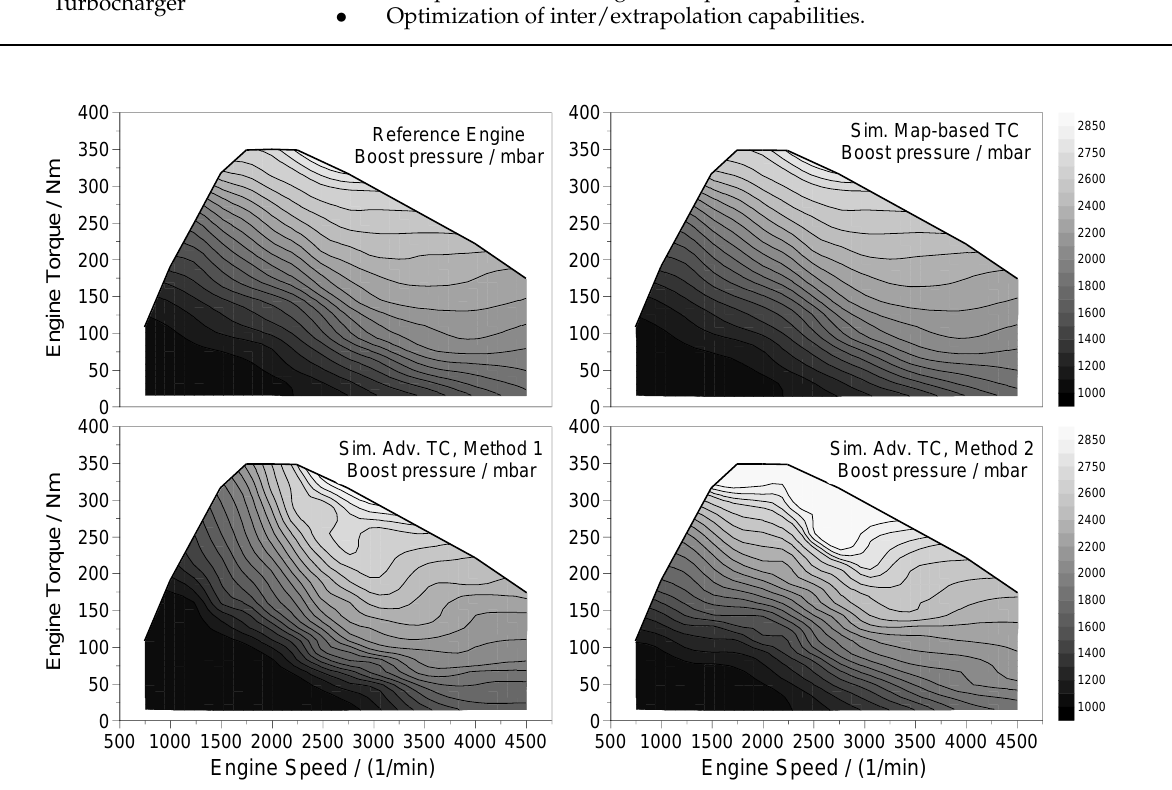
Figure 4. MiL verification of the engine model compared to test bench measurements for the different TC modeling approaches tested (map-based, Method 1, and Method 2).